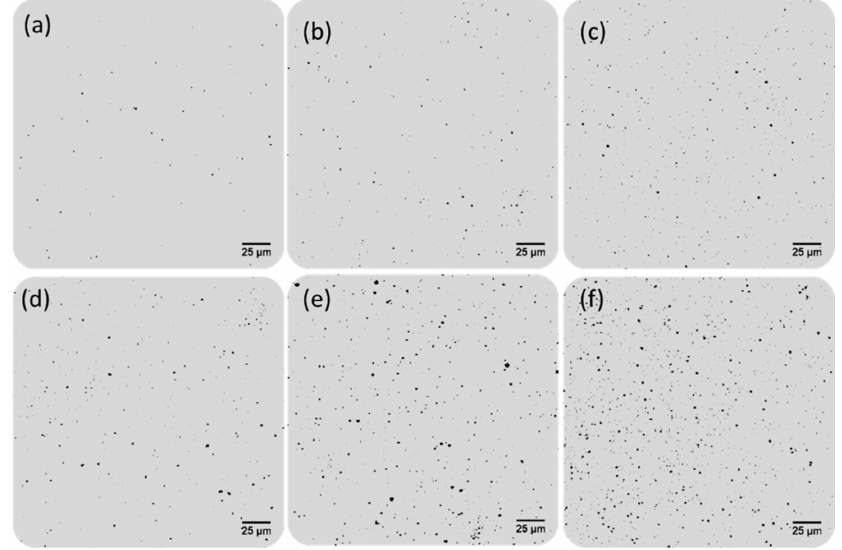
Figure 6. Confocal microscopy images of small areas (230 × 230 μ m 2 ) of the microscope slide wells obtained after the PSA QD ‐ based immunoassay, followed by gold deposition on the Mn ‐ ZnS QD tags at different PSA concentrations: ( a ) 0 PSA, ( b ) 0.01 PSA, ( c ) 0.1 PSA, ( d ) 1 PSA, ( e ) 10 PSA, and ( f ) 100 pg ∙ mL − 1 PSA.